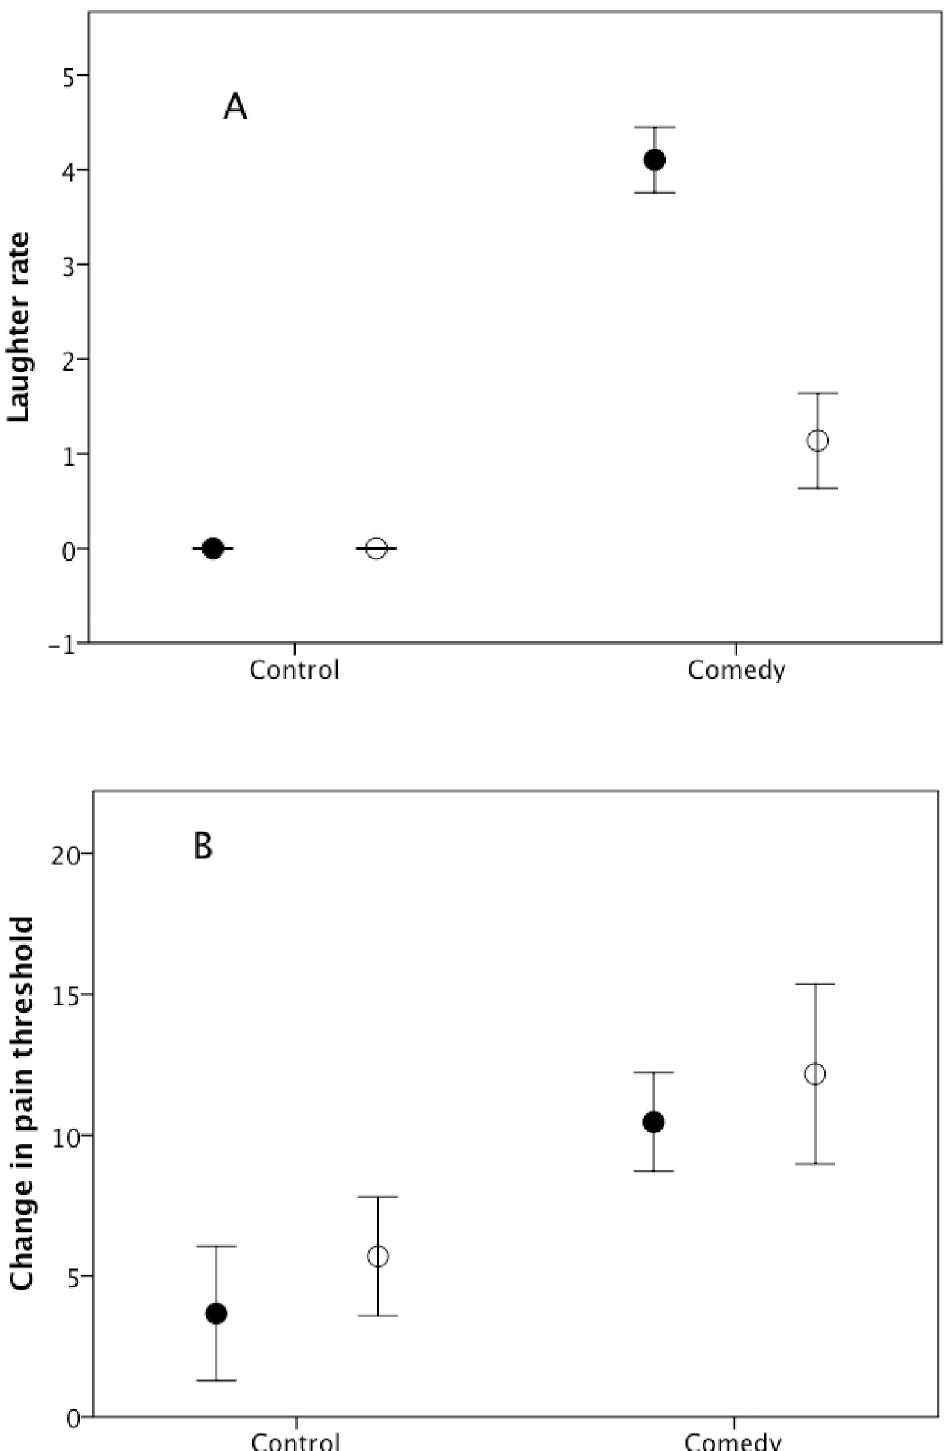
Fig 4. Mean ± se (a) frequency of laughter (number of laughs given) and (b) change in pain threshold, for men (unfilled symbols) and women (filled symbols) in Experiment 2.